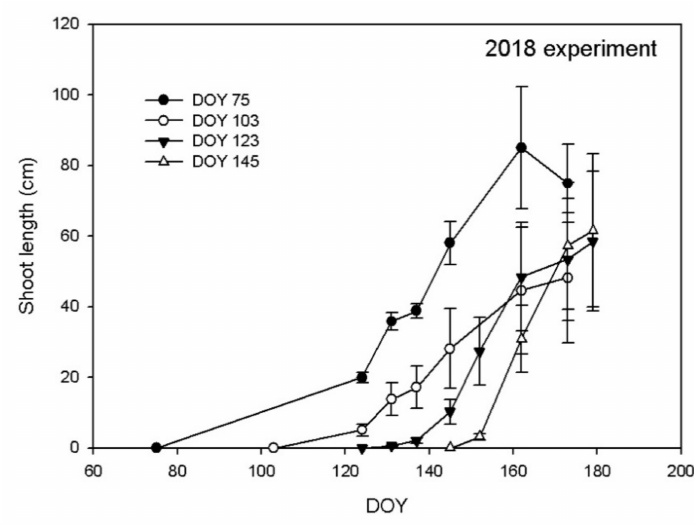
Figure 10. Shoot length over the experiment carried out in 2018 in Montepulciano vines removed from the cold storage on DOY 75, 103, 123, and 145. Mean ± SE ( n = 4). Different letters indicate statistically significant means per p < 0.05 (Tukey